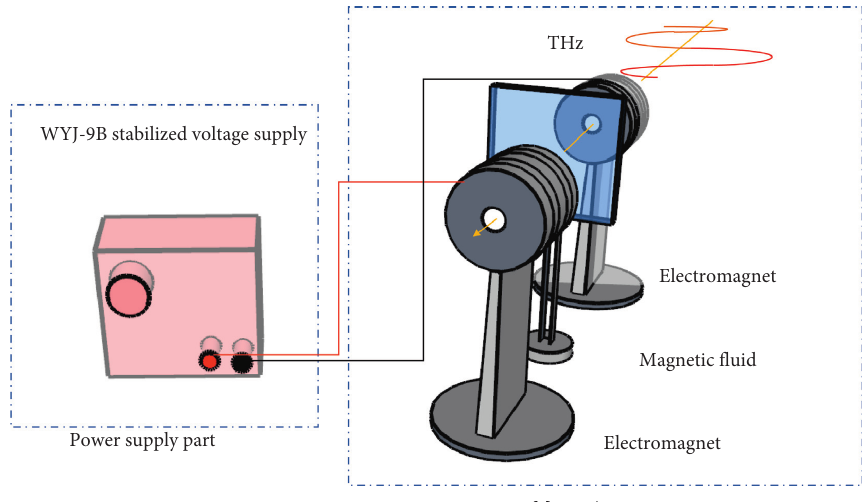
Figure 3: Diagram of a parallel magnetic field system.